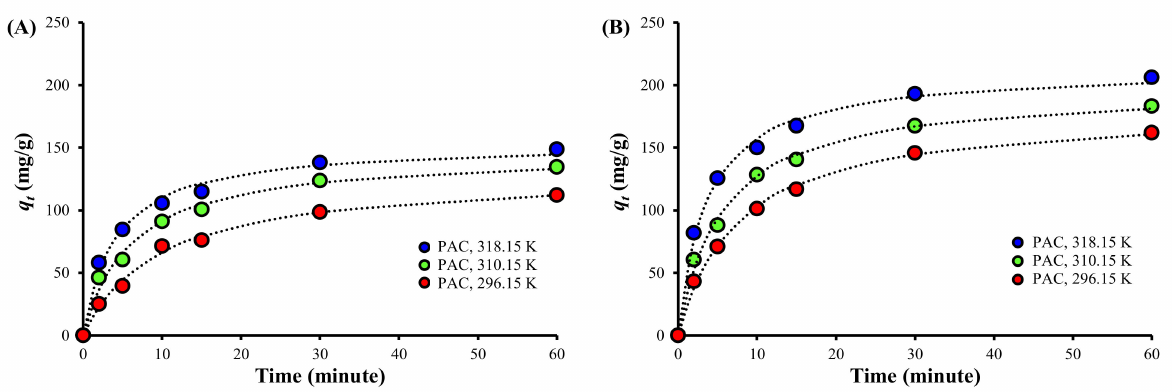
Figure 3. The experimental results of TC adsorption kinetics of ( A ) PAC and ( B ) PAC800 at differ- ent temperature, with the results of the fit to the pseudo second-order adsorption kinetic model (dotted